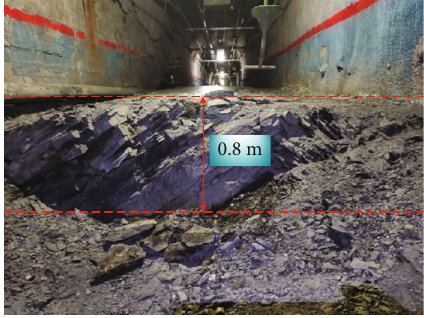
Figure 1: Failure of roadway fl